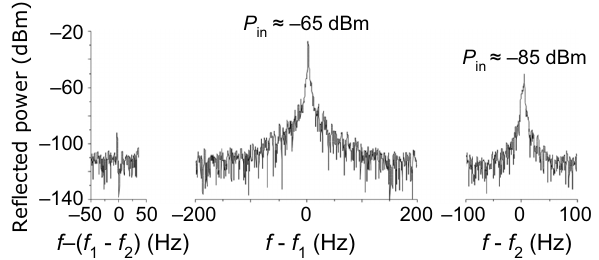
FIG. 11. Measurement of the intermodulation product, f 1 − f 2 , to characterise crosstalk. The intermodulation product is only observable in the multiplexing experiments when the input power of f 1 ( f 2 ) is raised by approximately 30 dB (10 dB) above the typ- ical experimental level. The resulting product is at least 60 dB (40 dB) below the reflected f 1 ( f 2 )